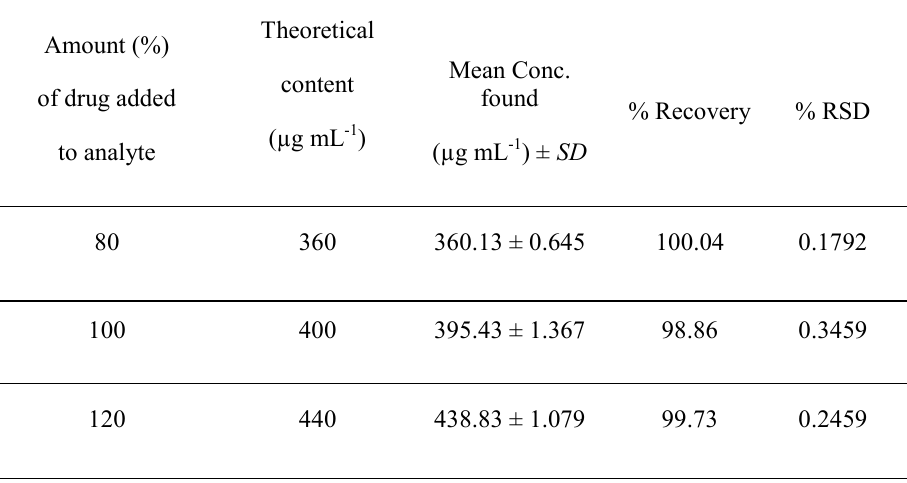
Table 4. Accuracy - Recovery data for Dorzolamide ( n =